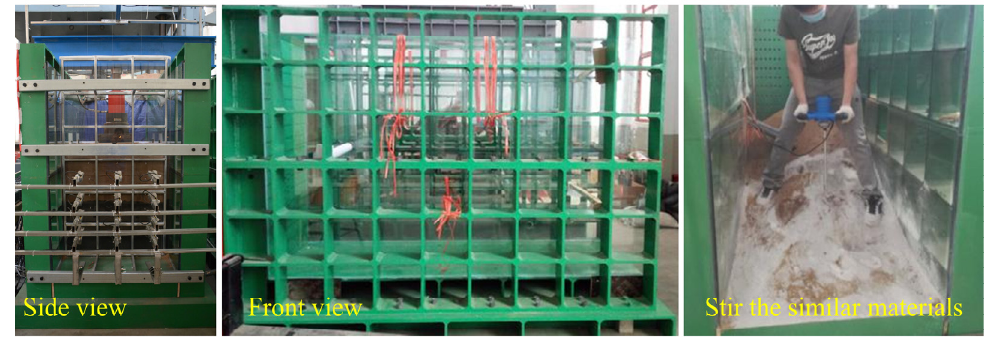
Figure 8. Model test bench and model soil backfill.